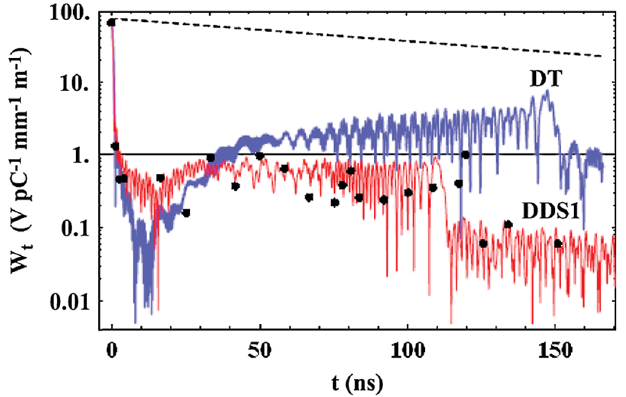
FIG. 9. (Color) Simulation of W t , envelope of wakefield, for DDS1 (in red), the first damped and detuned structure, compared to a detuned structure DT (in blue). Also indicated are points obtained from an experimental measurement of the wakefield and the damping (indicated by the black dashed line) which is attributable to purely Ohmic losses.